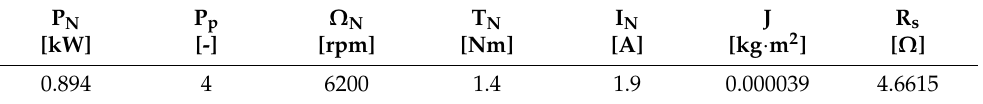
Table 2. Parameters of the motor used in simulation and experimental results.